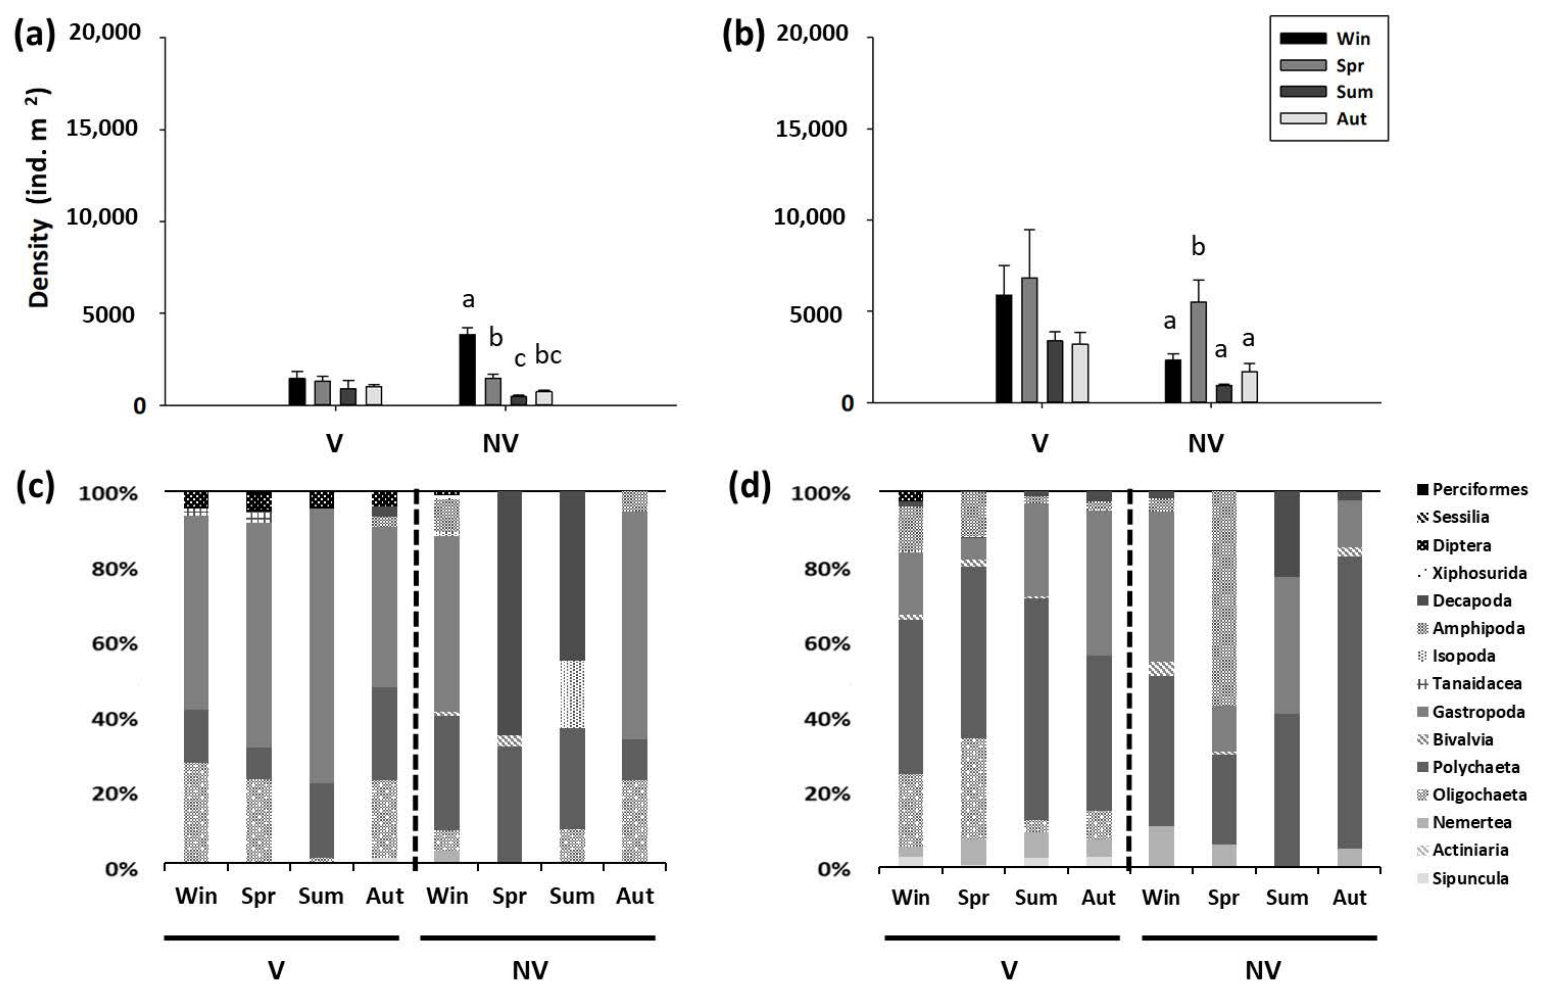
Figure 2. Seasonal variations in the density (mean ± SE) and macrobenthic community composition in the Avicennia marina mangroves in ( a , c ) BD and ( b , d ) BM. v, mangroves; nv, nonvegetated mudflats; win, winter; spr, spring; sum, summer; aut, autumn. Within each site, different letters above columns denote significant ( p < 0.05) differences among seasons with the Tukey’s post-hoc